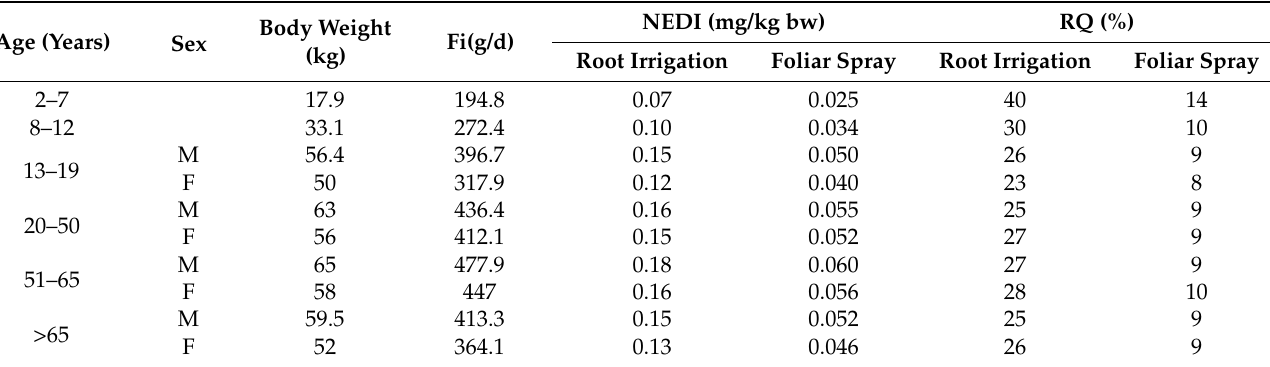
Table 5. The dietary risk assessment of fluopyram in carrot